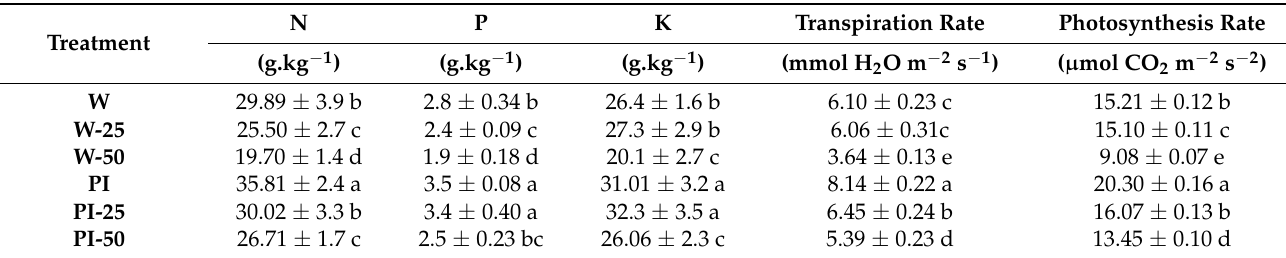
Table 1. Macronutrient content, transpiration rate and photosynthesis rate of cucumber leaves at 60 days post P. indica inoculation, under well and limited water irrigation